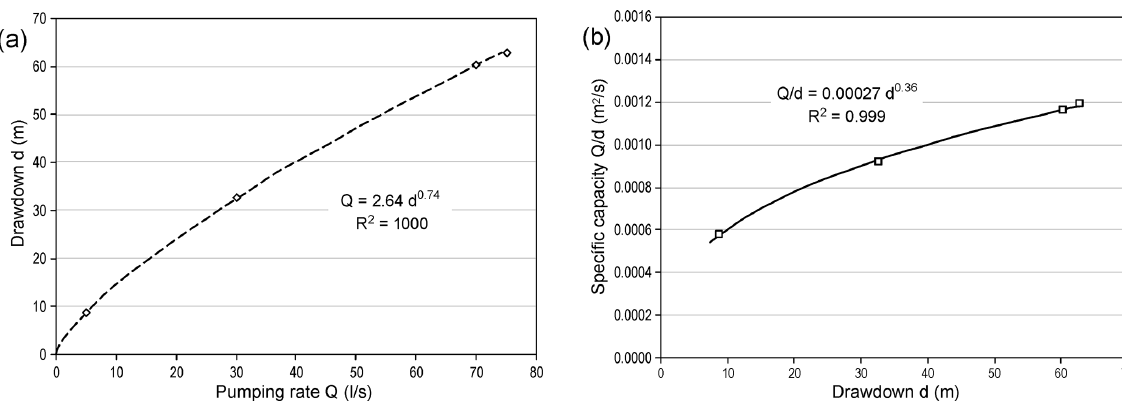
Figure 7. (a) Drawdown versus the pumping rate (b) and the specific capacity versus drawdown in the case study.